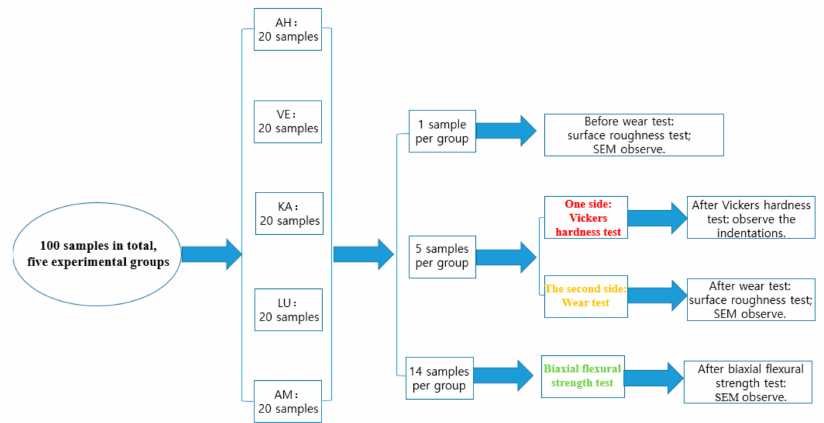
Figure 1. The protocol diagram with the number of samples in each group and